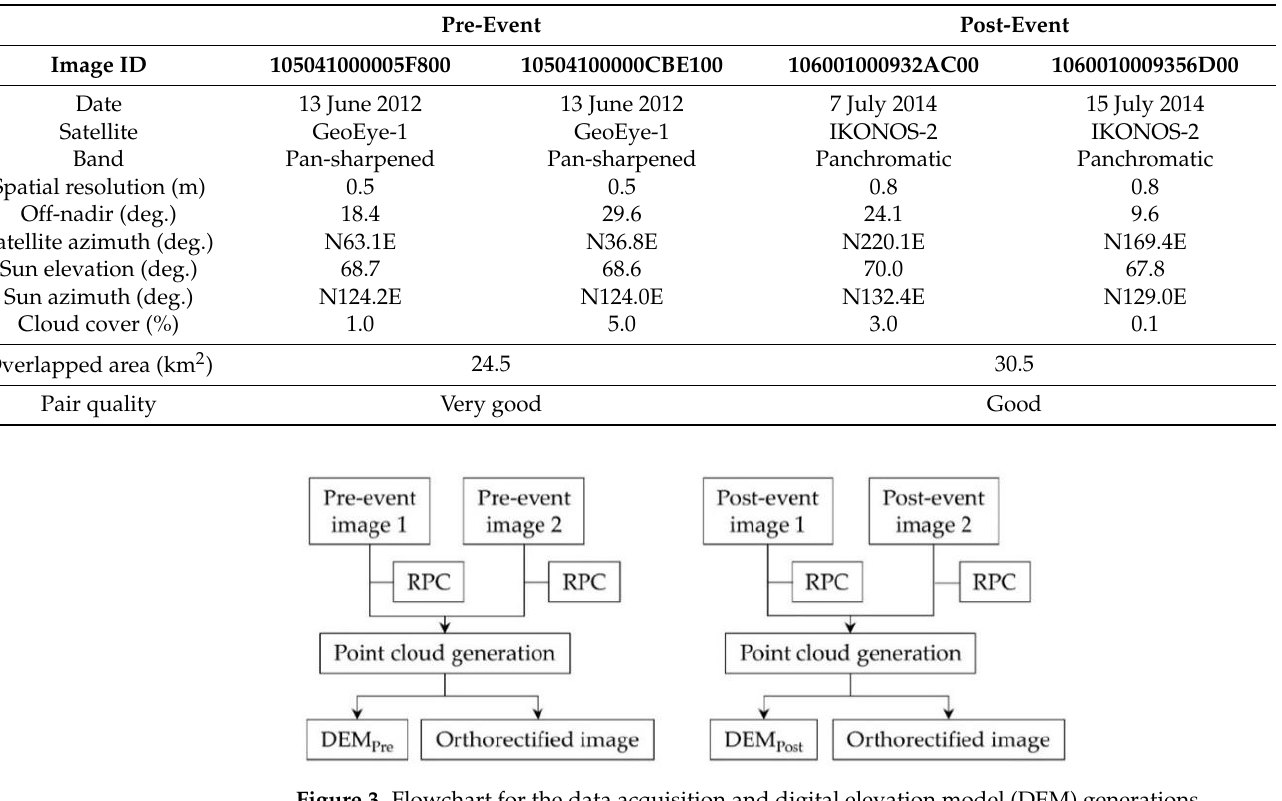
Figure 3. Flowchart for the data acquisition and digital elevation model (DEM) generations.